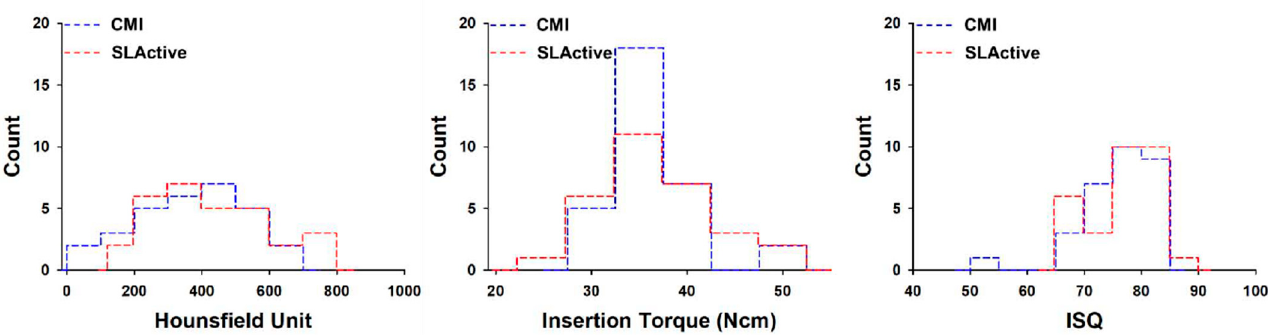
Figure 6. Histogram of average Hounsfield units, maximum insertion torque, and implant stability quotient values with type of implant system. ISQ = implant stability quotient.